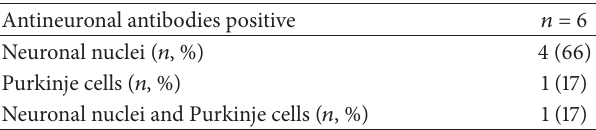
Table 3: IF pattern of antineuronal